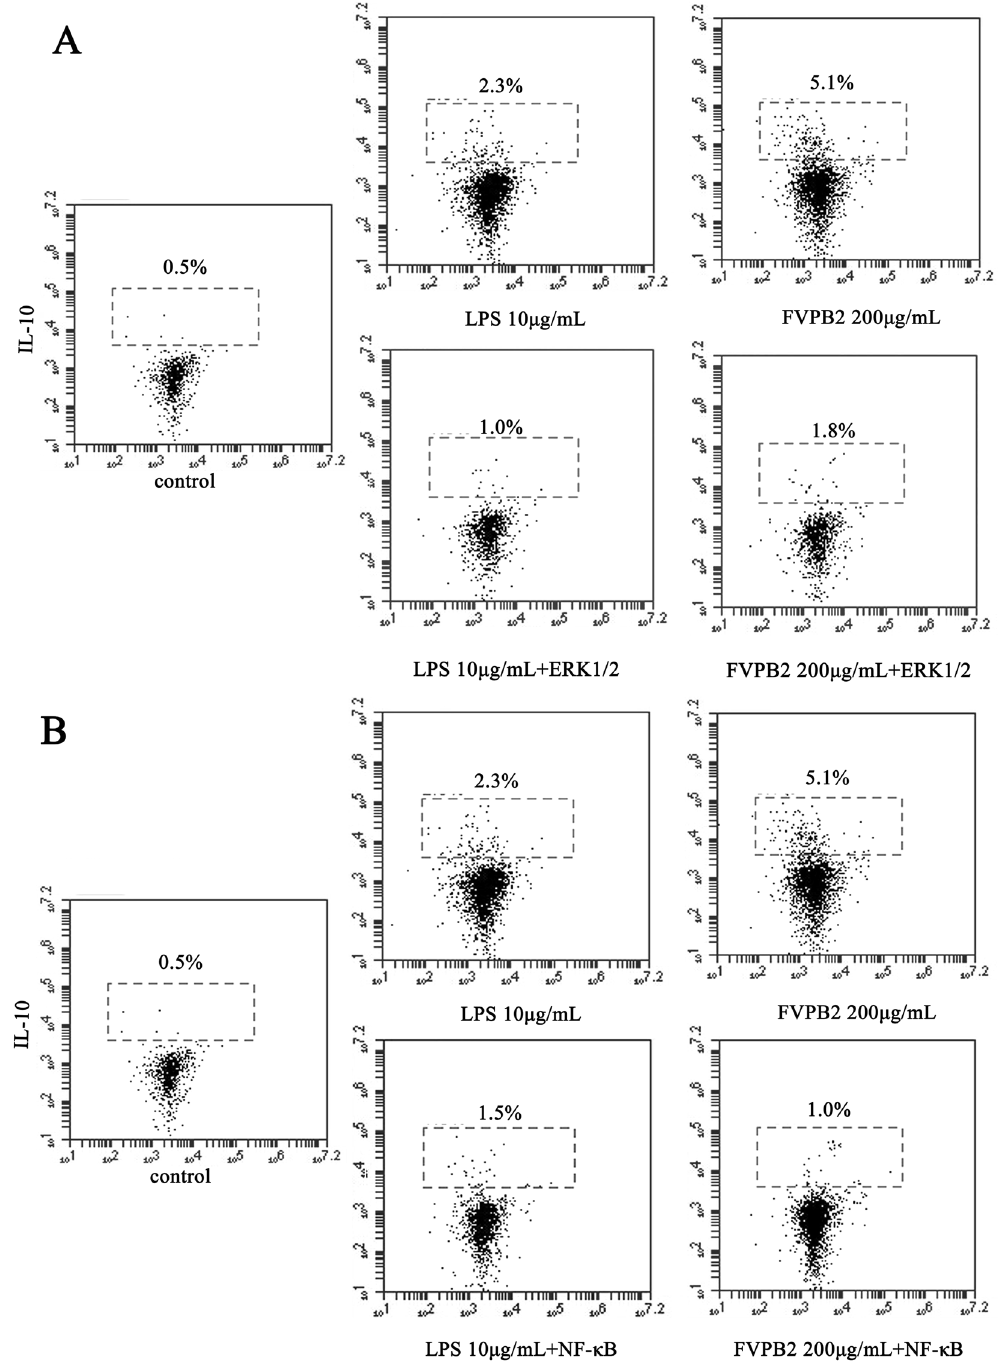
Figure 8. The influence of FVPB2 on the ERK1/2 and NF- κ B signaling pathways. B cells were preincubated with 50 μ g/mL ERK1/2 or 50 μ g/mL NF- κ B inhibitor for 1 h respectively, followed by treatment with 200 μ g/mL FVPB2, 10 μ g/mL LPS or PBS as the control for 3 days. Brefeldin A (BFA) was added for the last 5 h, and then the intracellular levels of IL-10 were analyzed by